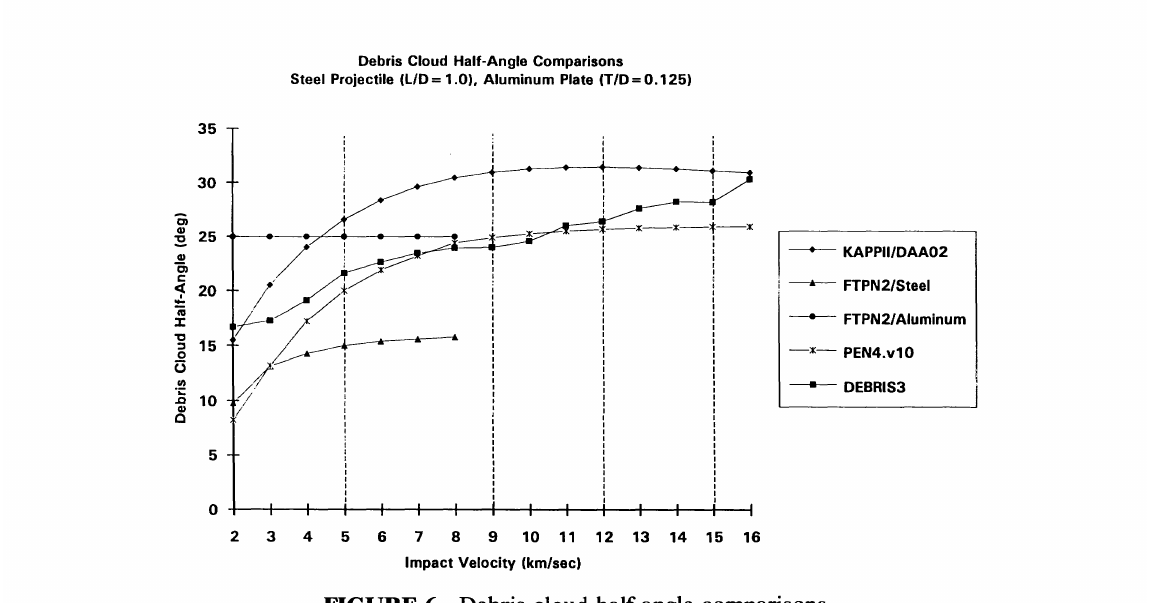
FIGURE 6 Debris cloud half-angle